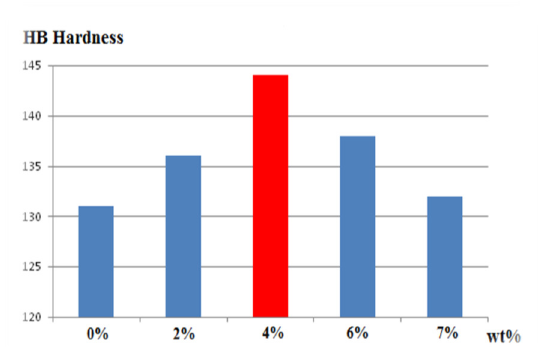
Fig. 4. Hardness (HB) result with different (cid:11) (cid:20) % of ZrO 2 .